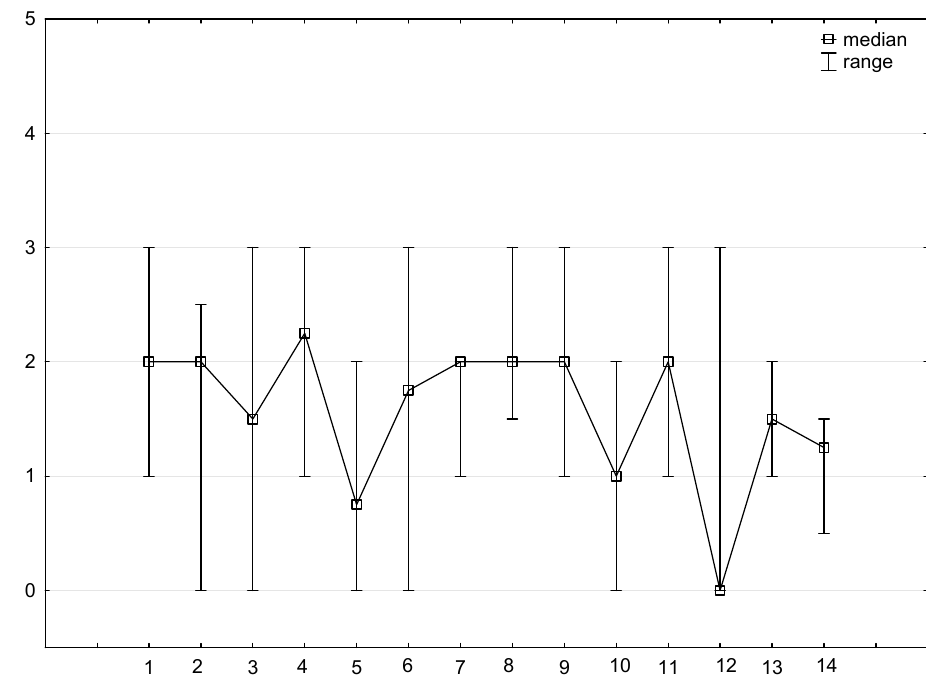
Figure 1. Stress management strategies. Table 2. Stress management strategies according to